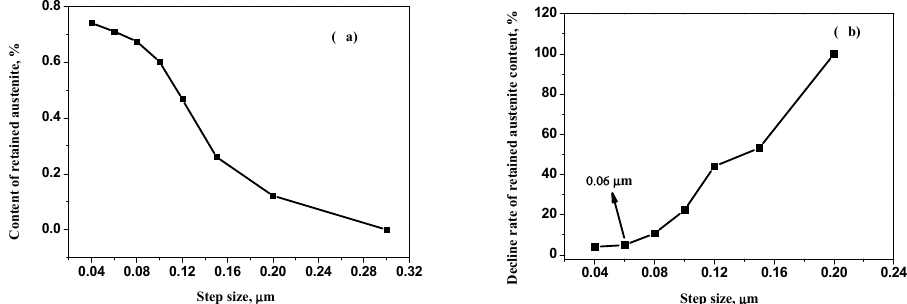
Figure 8. Curves of the measured retained austenite content ( a ) in X90 steel and its decline rate ( b ) with step size.